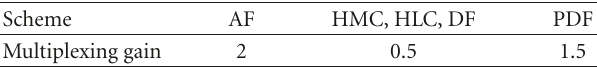
Table 1: Multiplexing gains of the transmission schemes in the high SNR